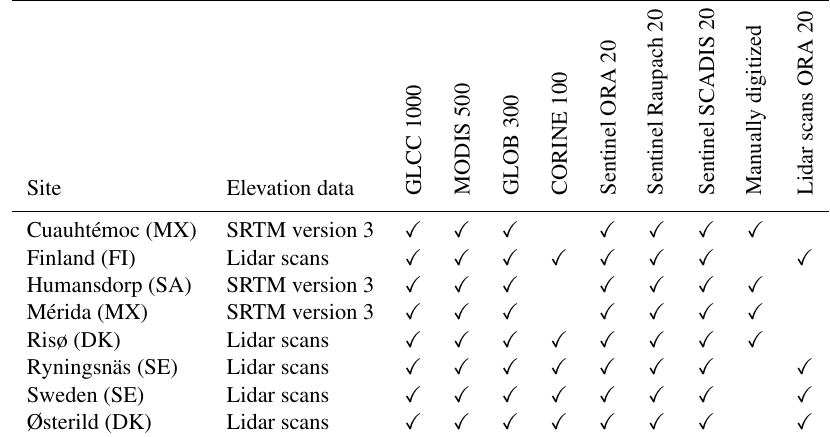
Table 3. Overview of the input data that are used for each site to estimate wind resources. The meaning of the different abbreviations are discussed in the